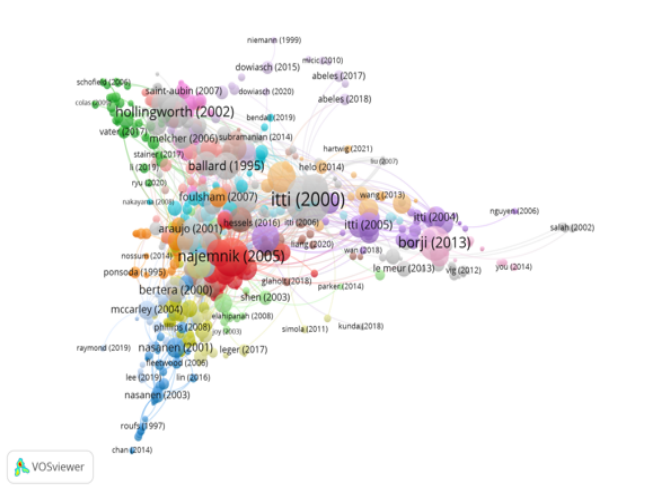
Figure 3. Citation network in Group